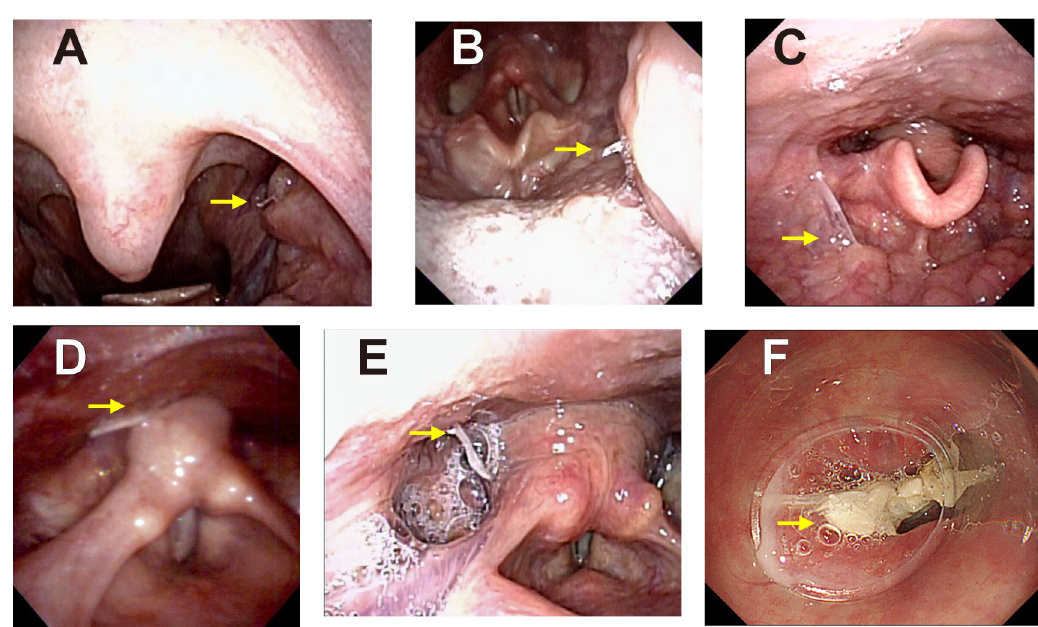
Fig 3. Typical images of fish bones in each location. A: herring bone in the palatine tonsil (upper pole), B: mackerel bone in the palatine tonsil (lower pole), C: flounder bone in the lingual tonsil (tongue base), D: amberjack bone in the posterior wall of hypopharynx, E: barracuda bone in the pyriform sinus, F: flounder bone in the cervical esophagus. Yellow arrows: fish bones.